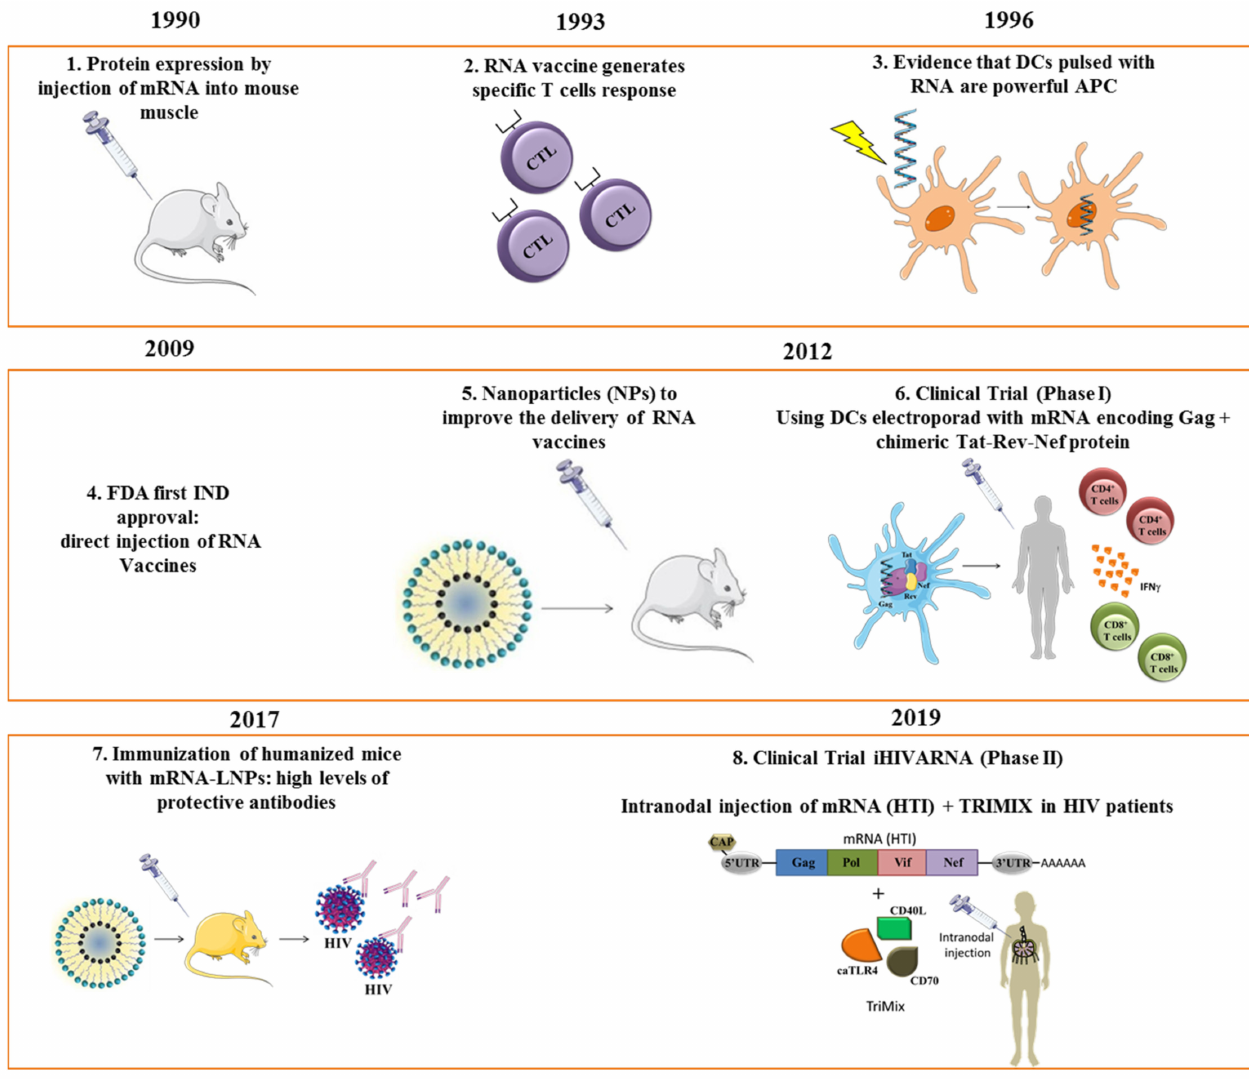
Figure 1. Milestones in RNA vaccines: steps and milestones in the development, application, and clinical use of mRNA- based vaccines. APC, antigen-presenting cell; DC, dendritic cells; NPs; nanoparticles; LNP, lipid nanoparticle; MVA, Modified Vaccinia Ankara. References for each time point: 1 [5], 2 [16], 3 [17], 4 [13], 5 [15], 6 [18], 7 [19], 8